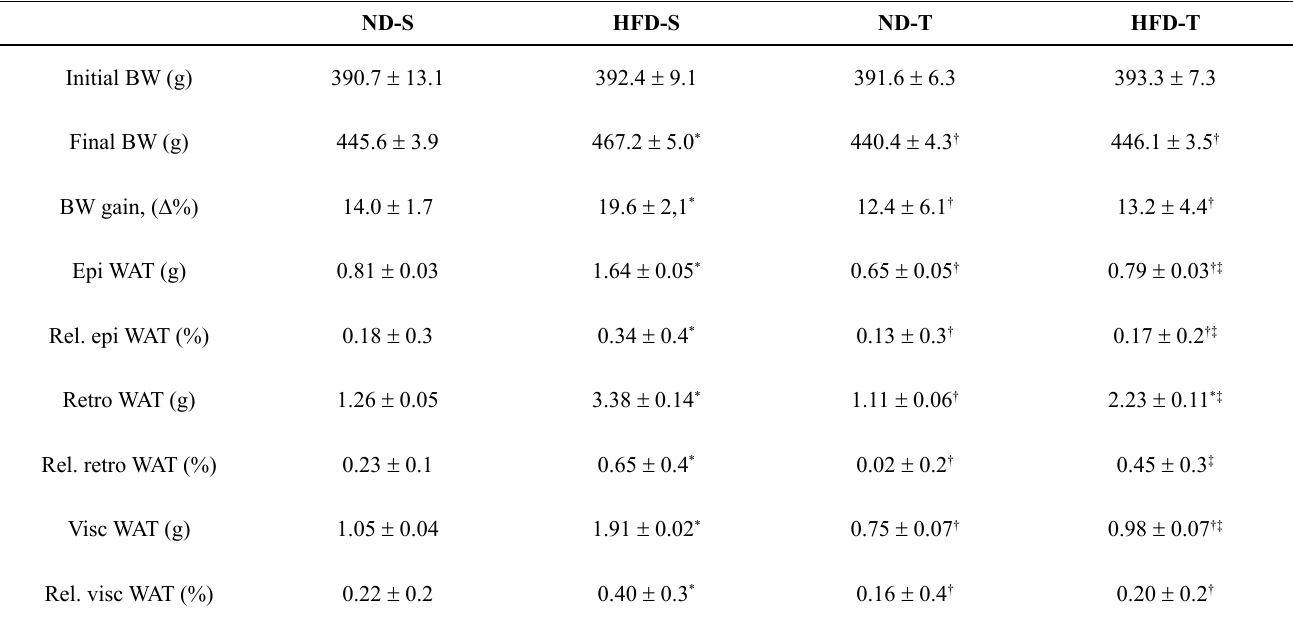
Table 1. Descriptive data for final BW mass, BW gain (relative D%), absolute and relative weights of epididymal, retroperitoneal and visceral adi - pose tissue weights from sedentary normal diet (ND-S, n=8), sedentary high-fat diet (HFD-S, n=8), trained normal diet (ND-T, n=8) and trained high-fat diet (HFD-T, n=8) groups for 9